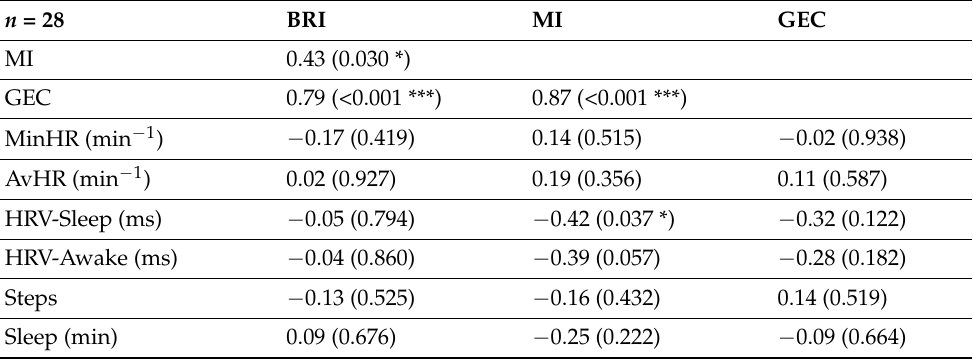
Table 6. Spearman ´ s partial rank correlation coefficients and statistical significances for BRIEF-A indices and Firstbeat ® results with gender and BBI-15 and BDI scores controlled for ( p < 0.05 (*), p < 0.001